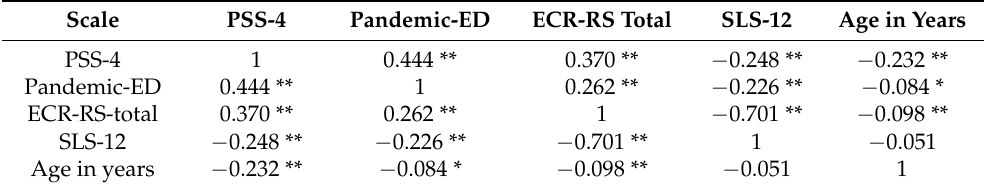
Table 4. Correlational analyses PSS-4, Pandemic-ED, ECR-RS total and SLS-12 (rho Spearman) (N =